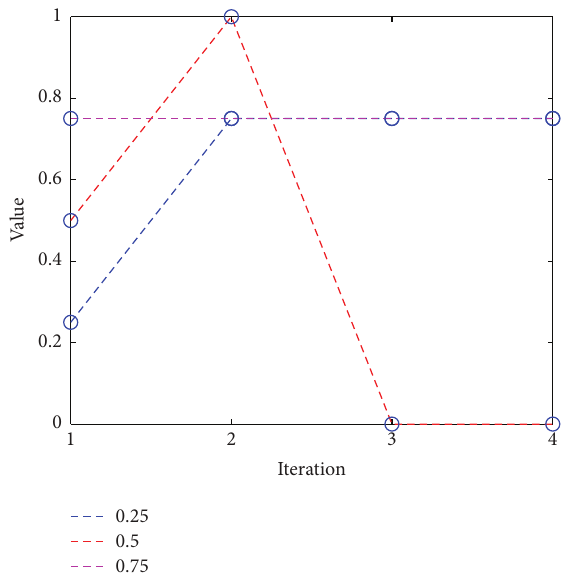
Figure 2: Loss of chaotic property at three specific initial